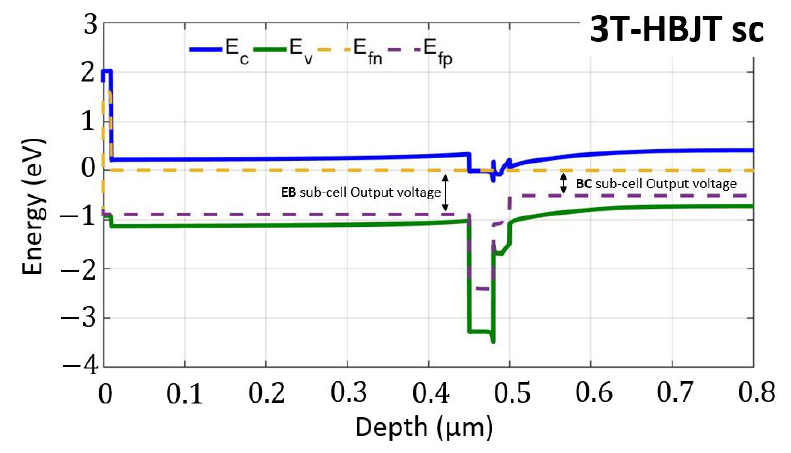
Figure 8. Energy band diagram of the p-n-p 3T-HBT (Figure 3) with each junction biased at maxi- mum power point. The dashed yellow and pink lines are the electron and hole quasi-Fermi levels, respectively.